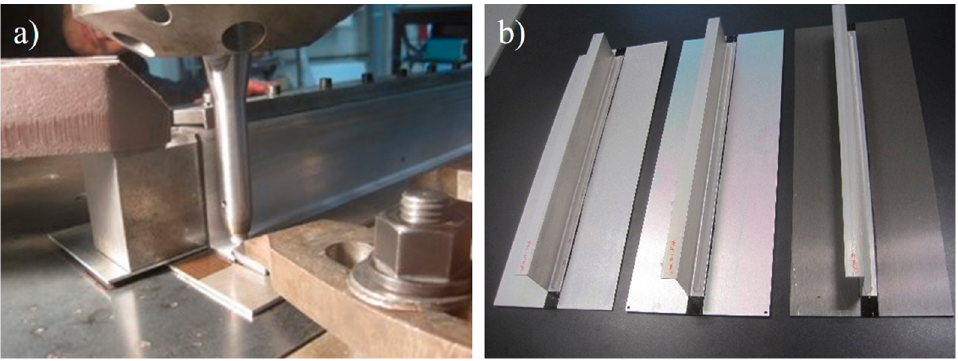
Figure 2. ( a ) Setup for the FSW process and ( b ) example of completed FSW coupons C4, C5, and